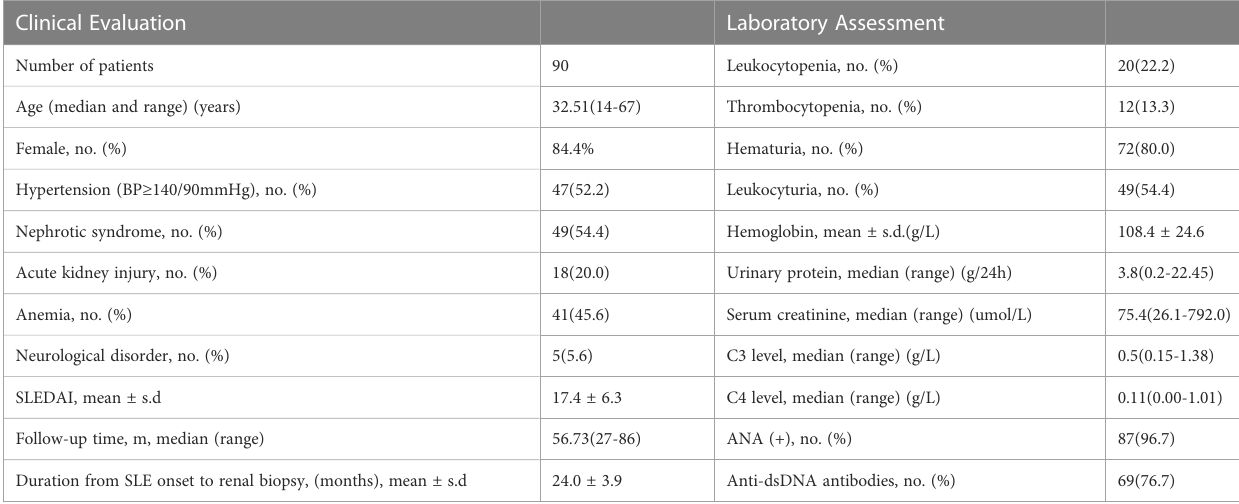
TABLE 1 General clinical pro fi les of patients with lupus nephritis at renal